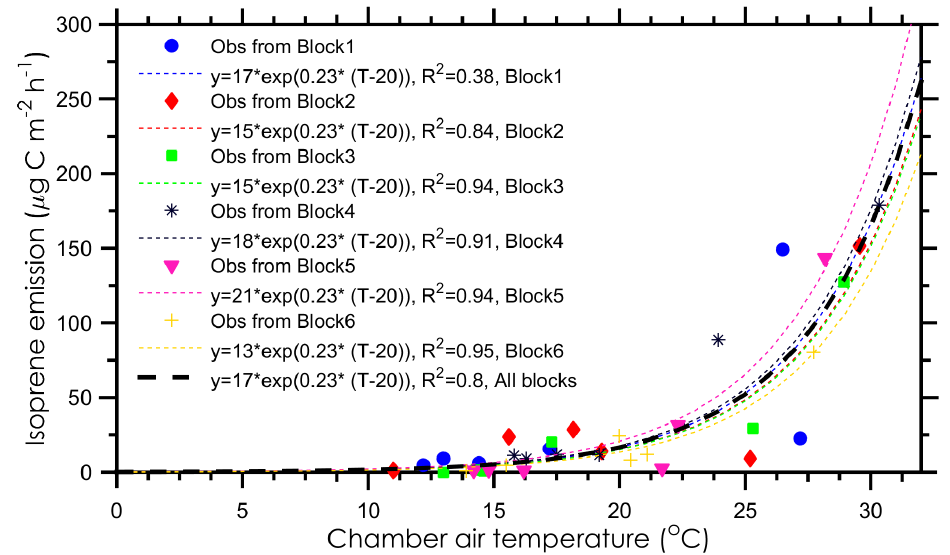
Figure 1. The observed isoprene emission rates in relation to the chamber air temperature in July over three field seasons (2006, 2007, 2012) in the Abisko tundra